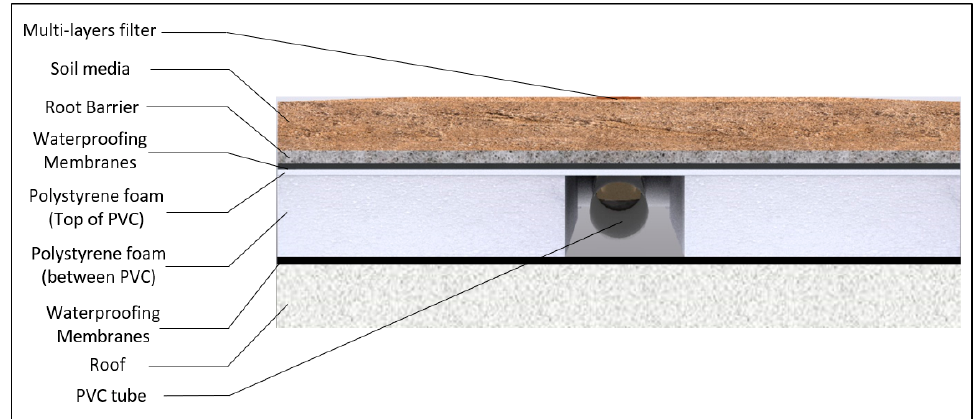
Figure 7. Soil media on the top of the root barrier layer (8 cm or more, depending on the plants). (7) soil media; (9) exit upside-down U-shaped tube.